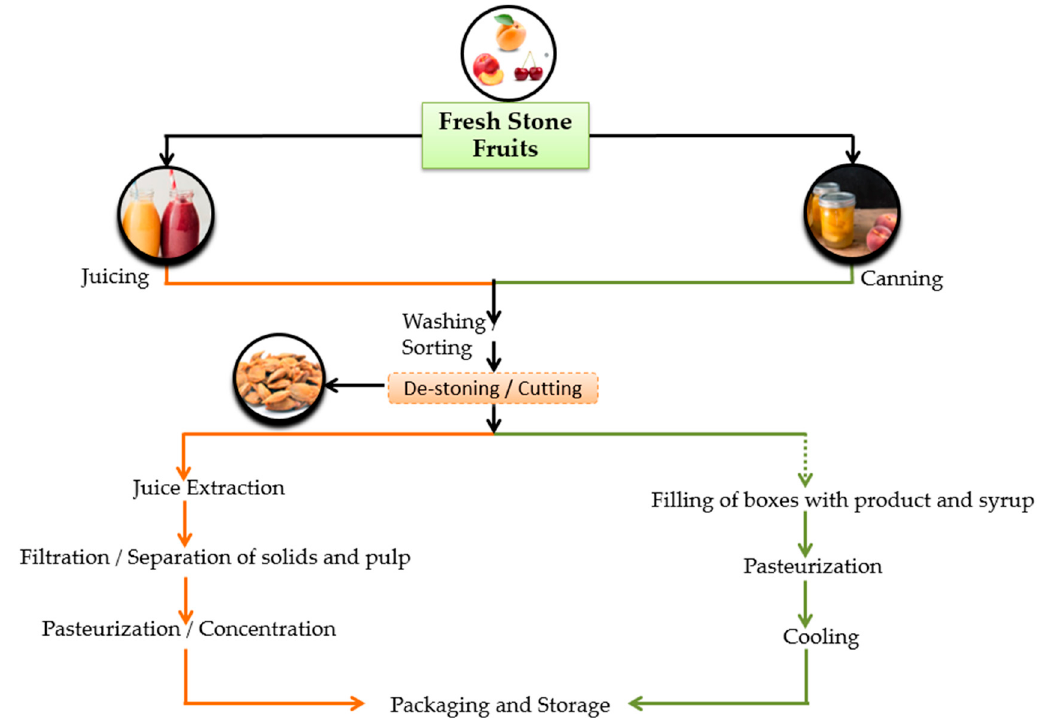
Figure 4. The processing of fresh stone fruits in Greece.